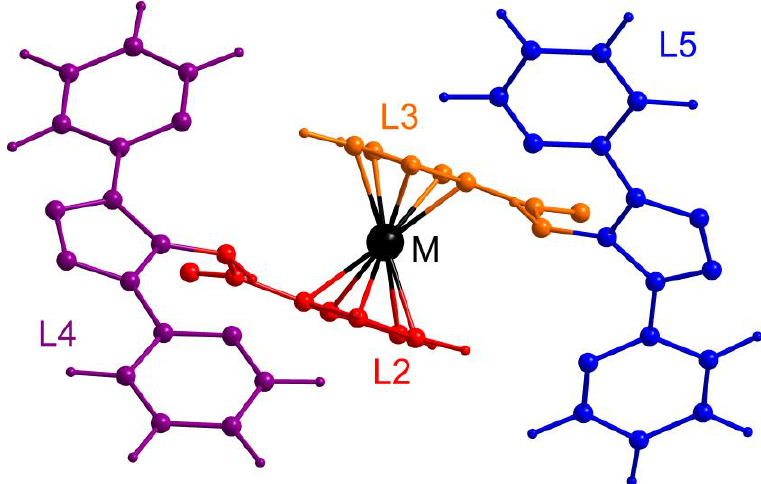
Figure 7. The DFT optimized molecular structure of L used for TD-DFT calculations with graphically marked fragments.